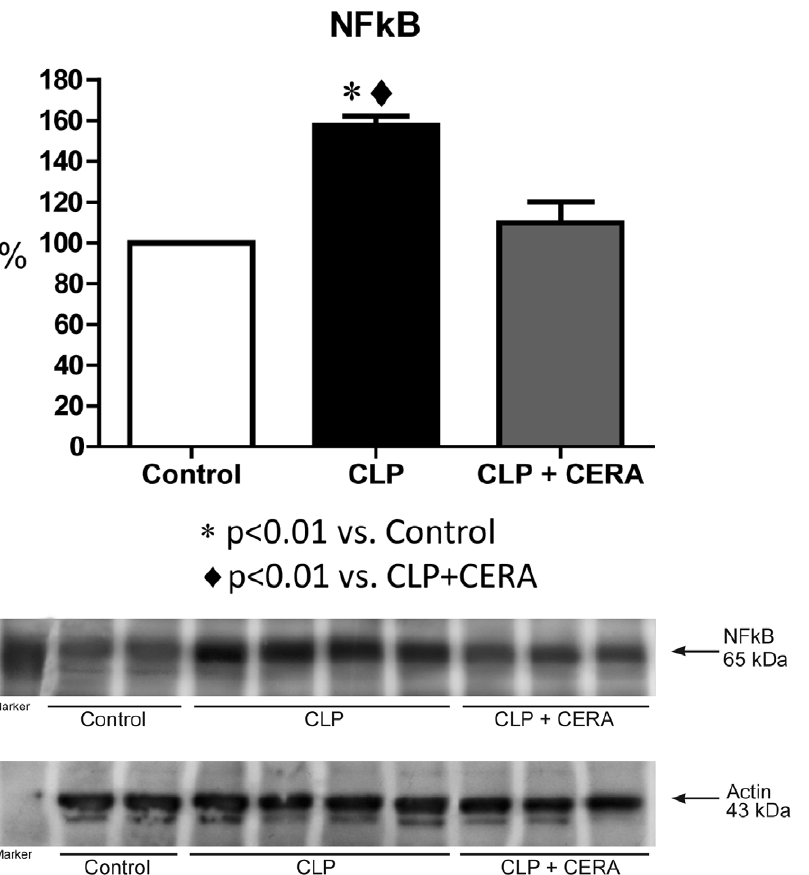
Figure 5. Immunoblots reacted with anti-nuclear factor kappa B antibody (1 : 500 ), revealing a 65-kDa band. Semiquantitative immunoblots prepared from kidney samples. Densitometric analysis of samples from control rats, rats submitted to cecal ligation and puncture only, and rats treated with continuous erythropoietin receptor activator prior to undergoing cecal ligation and puncture. Differences among the means were compared by analysis of variance followed by the Student-Newman-Keuls test. p . 0.05 for control vs. CLP + CERA. CLP, cecal ligation and puncture; CERA, continuous erythropoietin receptor activator; NF- k B, nuclear factor kappa B.